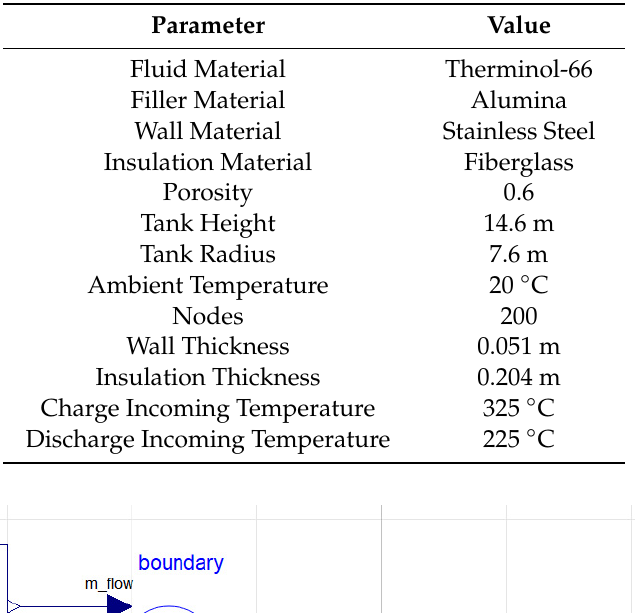
Table 1. Test case parameters.